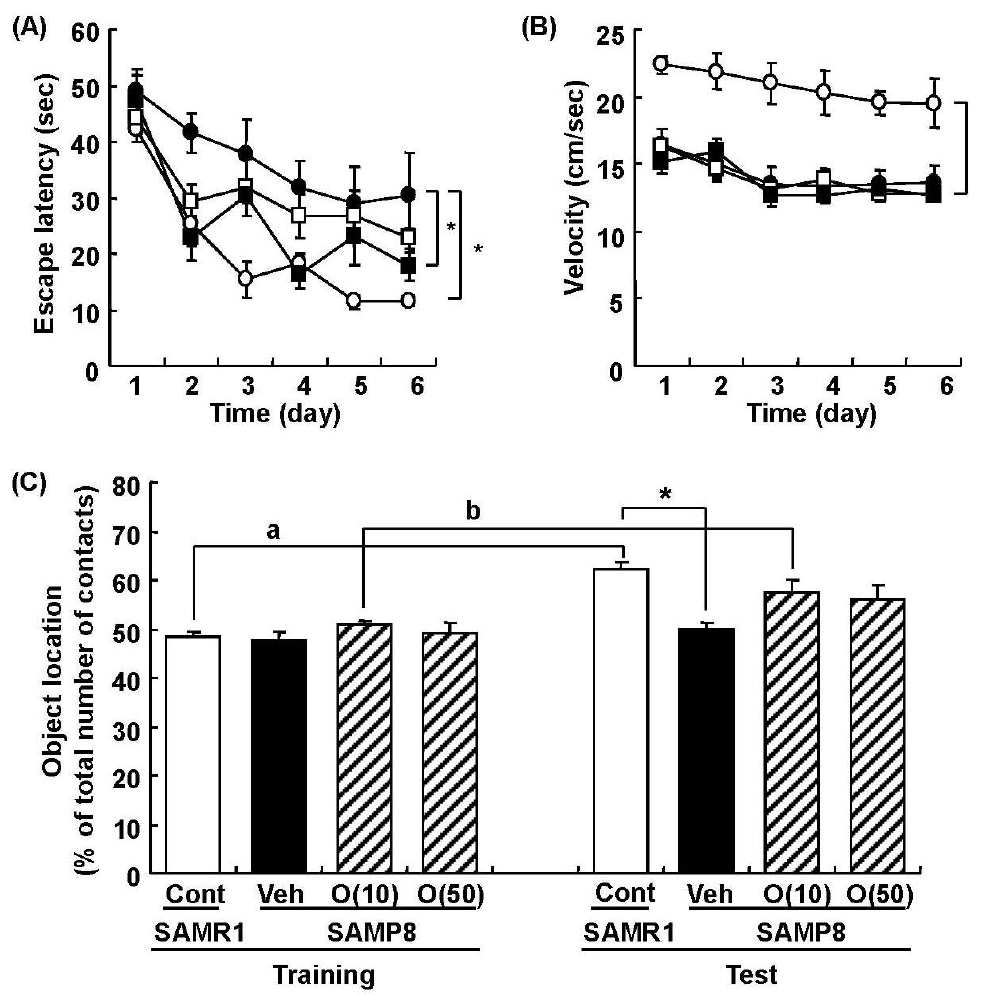
Figure 6. Effects of oligomers on spatial memory deficit in SAMP8. Eighteen-week-old SAMP8 were administered vehicle (Veh, water p.o., n = 6; closed circles) or oligomers (10 mg/kg body weight/day, p.o., n = 6; open squares or 100 mg/kg body weight/day, p.o., n = 5; closed squares) for 5 weeks. SAMR1 were used as a control (Cont, n = 5; open circles). Fifteen days after the start of administration, memory acquisition tests were continued for 6 days in a Morris water maze. Administration was continued during the tests. Escape latencies to a hidden platform were measured ( A ). The swimming velocities of mice in the memory acquisition test are shown ( B ). Thirty-eight-week-old SAMP8 were administered vehicle (Veh, water p.o., n = 7) or oligomers (O (10), 10 mg/kg body weight/day, p.o., n = 7 or O (50), 50 mg/kg body weight/day, p.o., n = 7). Age-matched SAMR1 were used as a control (Cont, n = 7). Twenty-eight days after administration started, an object location test was performed. The preference index was defined as the number of times a mouse made contact with any one of the objects (training session) or the moved object (test session) out of the total number of times the mouse made contact with both objects (%) ( C ). * p < 0.05 vs. Veh. (A and B: Repeated measures two-way ANOVA followed by Dunnett’s or Bonferroni’s post-hoc test); * p < 0.05 (C: One-way ANOVA followed by Bonferroni’s post-hoc test); a p = 0.0005; b p = 0.0213 (C: paired t